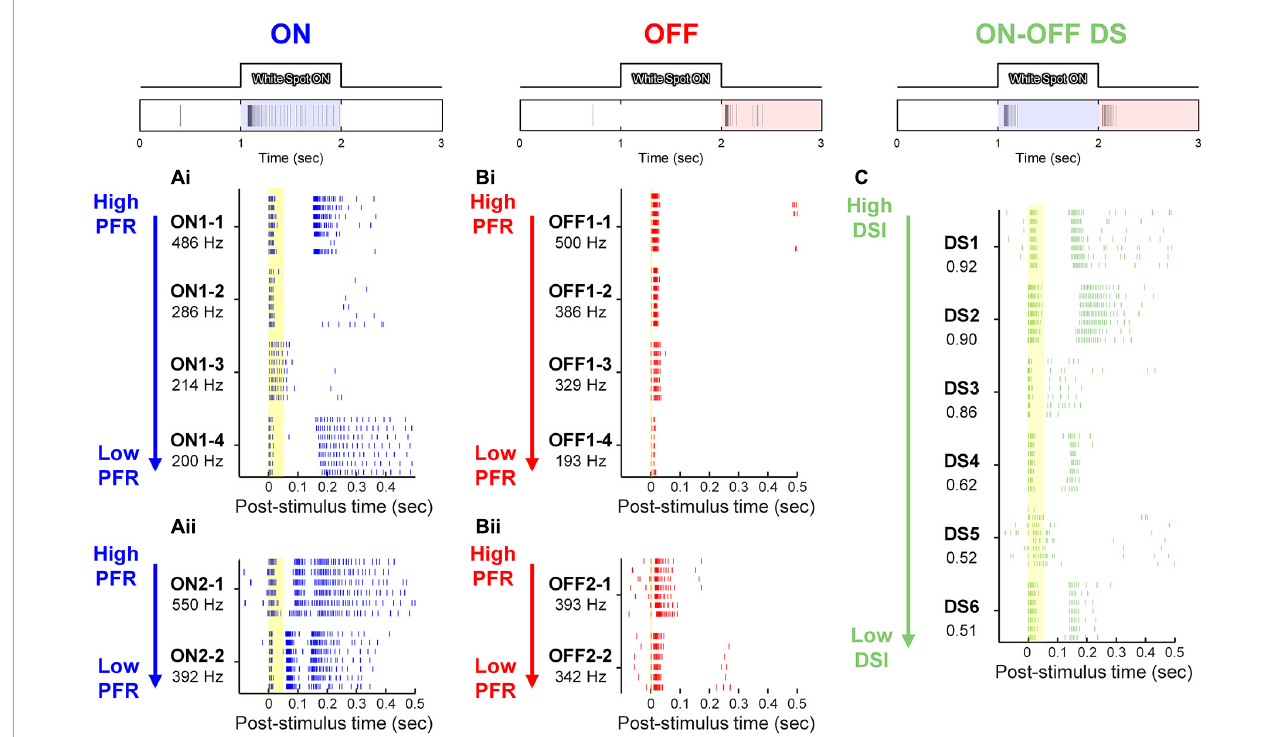
FIGURE4 Electrically-evoked responses from 6 representative RGCs in the three physiological types of rd8 retinas. At top of each panel, representative light-evoked responses of ON, OFF, and ON-OFF DS RGC to 1-s-long white spot flash are shown. (Ai,Aii) Raster plots of ON RGCs are shown in the order of peak firing rate (PFR), which is shown below each cell ID. Each vertical tick of raster plots indicates a single spike. Each cell contains responses to stimuli repeated for 6 or 7 times. Spiking patterns of ON RGCs were divided into either two (Ai) or three (Aii) bursts. (Bi,Bii) Same as panel (A) but for OFF RGCs. The responses of OFF cells were also divided into two types: abrupt spiking ending (Bi) , and gradual tapering off of spiking activity (Bii) . (C) Raster plots of ON-OFF DS RGCs are displayed in the descending order of direction selectivity index (DSI). Yellow vertical bands in raster plots indicate the range of early response of each cell type (i.e., 0–50, 0–6, and 0–55 ms for ON, OFF, and DS RGCs,